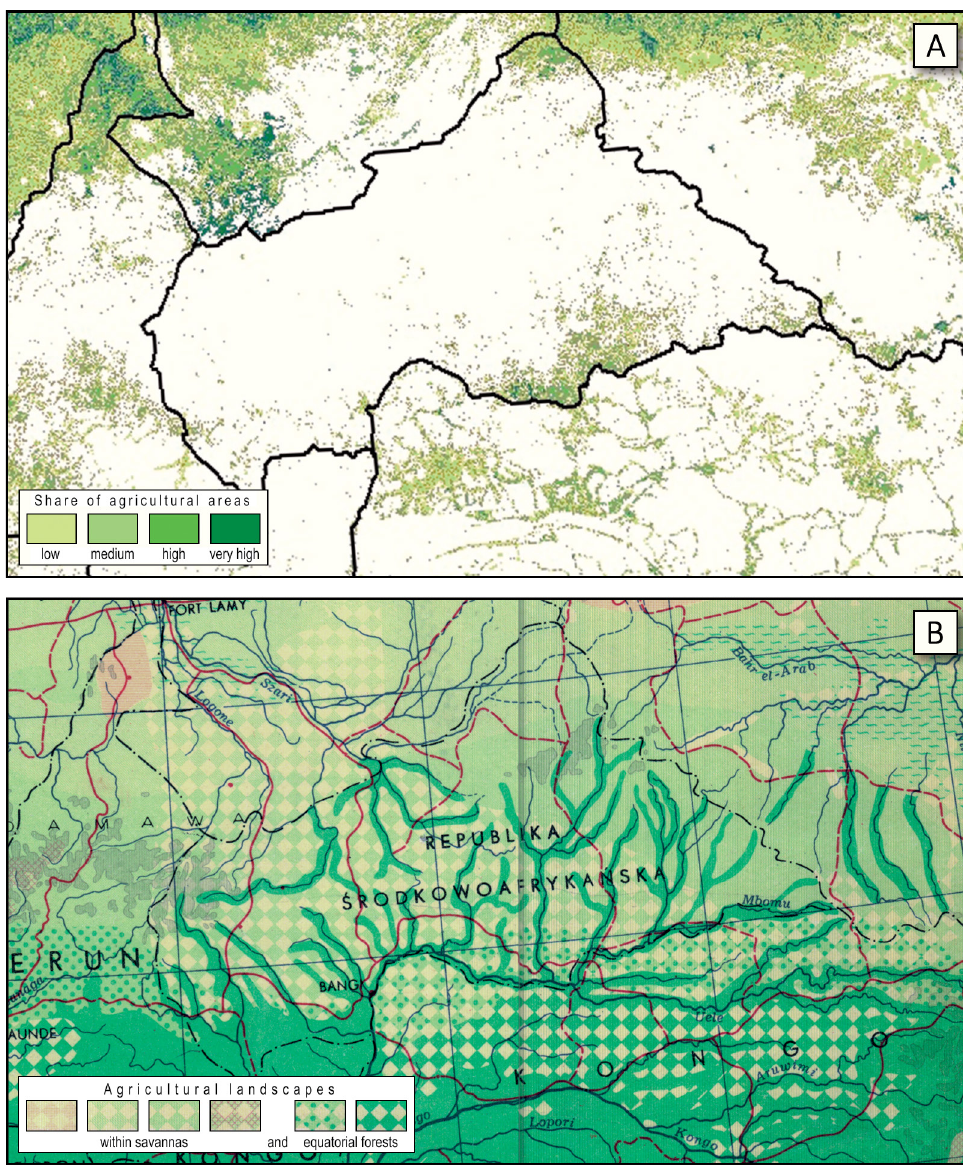
Fig. 7. Agricultural areas in Central Africa: A – on the map developed based on contemporary satellite data (the author’s elaboration based on https://earthzine.org/wp-content/uploads/2012/01/africa.jpg); B – on the map by F. Uhorczak (a part of the map of Northern Africa, scale 1:15,000,000 from volume IV of “Universal